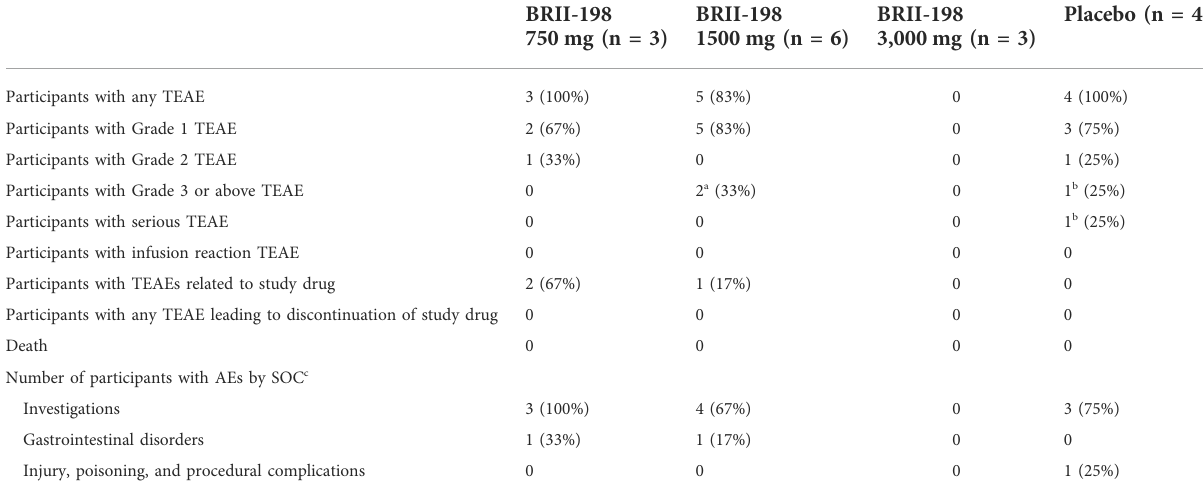
TABLE 3 Summary of adverse events of BRII-198-001